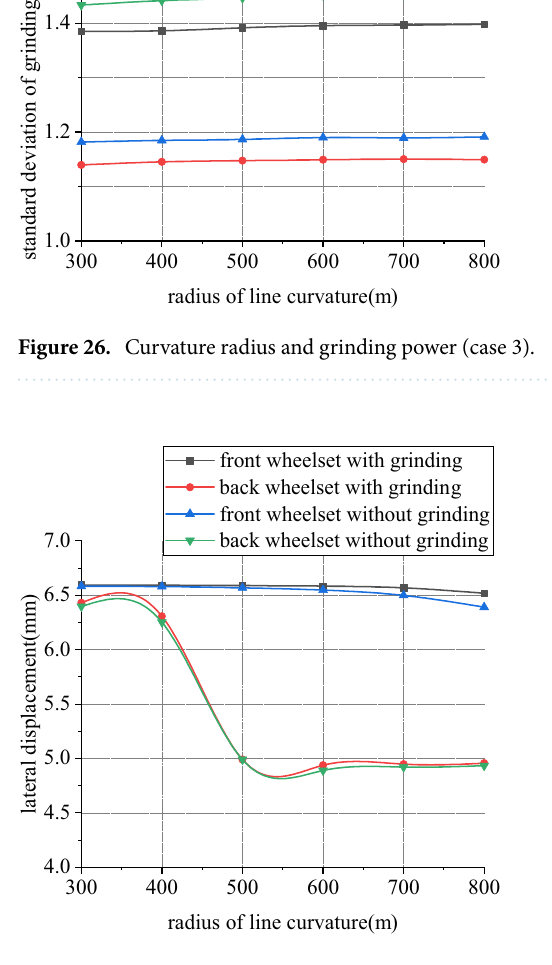
Figure 27. Curvature radius and lateral displacement (case